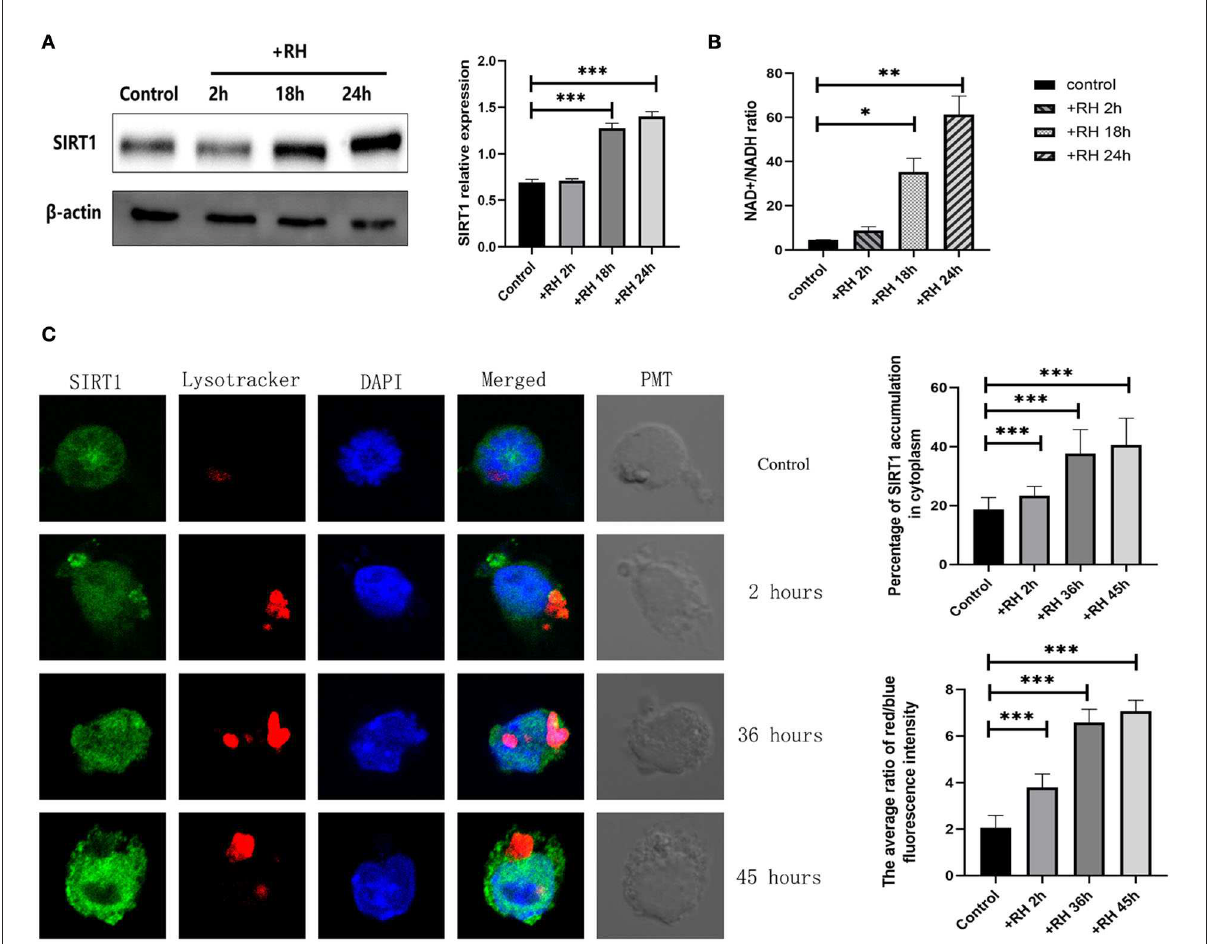
FIGURE1 Changes in the expression, activity, location, and degradation of Sirtuin 1 (SIRT1) at different stages of Toxoplasma gondii infection. RAW 264.7 macrophages were either infected with RH tachyzoites at a ratio of 5:1 (parasite/host cell) for 2h or left in the culture plate without infection. The NAD + /NADH (nicotinamide adenine dinucleotide) samples of the macrophages were extracted at 2, 18, and 24h after infection of uninfected cells. The specific details of NAD + /NADH ratio measurement are illustrated in the NAD + /NADH ratio assay of the Experimental Methods section. The total protein of the host cells was extracted at 2, 18, and 24h after infection, and the total SIRT1 level was detected by Western Blot. The confocal samples of the macrophages were extracted at 2, 36, and 45h after infection of uninfected cells. (A) T. gondii infection leads to an increment in the NAD + /NADH ratio of host cells over time, indicating the upregulation of SIRT1 activity. The ratio of NAD + /NADH in murine macrophages did not increase significantly at 2h of RH tachyzoite infection, but at 18 and 24h, the ratio of NAD + /NADH increased significantly and increased with the prolongation of infection time. (B) T. gondii infection upregulated SIRT1 levels in host cells over time. (C) Fluorescent graphics showing the SIRT1 expression and lysosome activity of macrophages infected with RH tachyzoites for 2, 36, and 45h. In the absence of T. gondii , SIRT1 in murine macrophages is predominantly expressed in the nucleus. With the prolongation of RH tachyzoite infection time, the expression of SIRT1 in host cells increased. Furthermore, the distribution of SIRT1 in murine macrophages also gradually shifted mainly from the nucleus to the cytoplasm, and gradually accumulated in the location of intracellular T. gondii . It also resulted in an upregulated activity of lysosomes, as seen by the red fluorescence. The intracellular T. gondii gradually accumulated in the lysosomes. These results were obtained from three independent experiments. The values shown are the means ± SEM from three independent experiments. SIRT1, green fluorescence; Lysotracker, red fluorescence; DAPI, blue fluorescence, PMT (photomultiplier tube), the light field with PMT as the detector and laser 488nm as the light source. * P < 0.05, ** P < 0.01, and *** P <